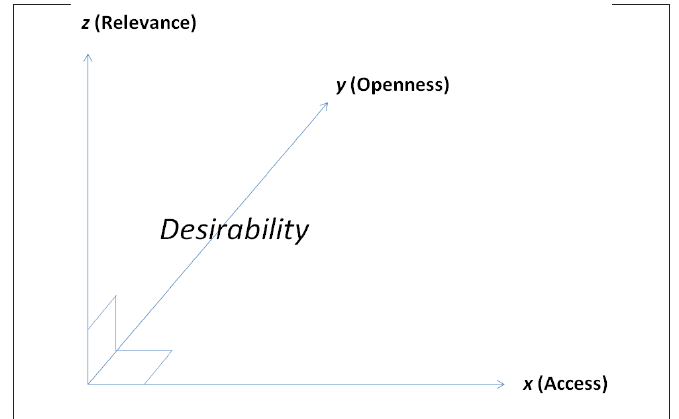
Figure 1 . Desirability of an